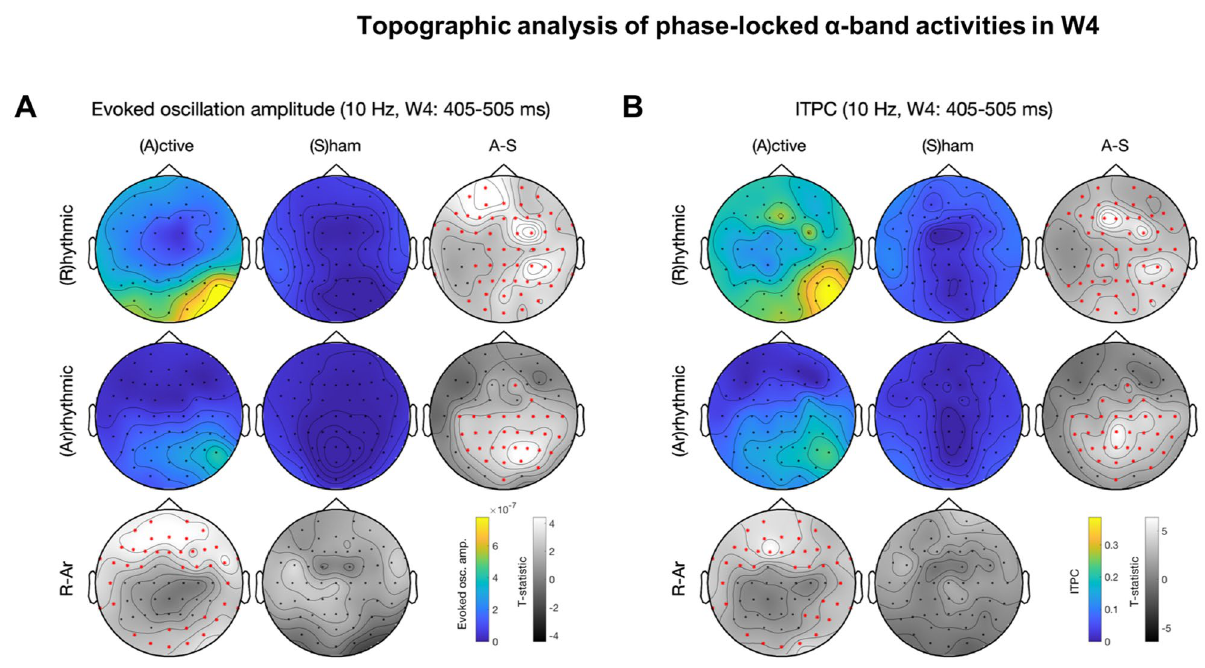
Figure 3. Topographic analysis of phase-locked α-band activities in W4. The panel layout is similar to that in Fig. 2. The red star symbols indicate significant channels after cluster-based permutation test for multiple comparison correction. ( A ) Evoked oscillation amplitude. ( B ) ITPC. Rhythmic-active stimulation elicits widespread activation. With arrhythmic-active stimulation as control, there are significant clusters in the frontal and the occipital regions. Note that the patterns between ( A ) and ( B ) are similar.